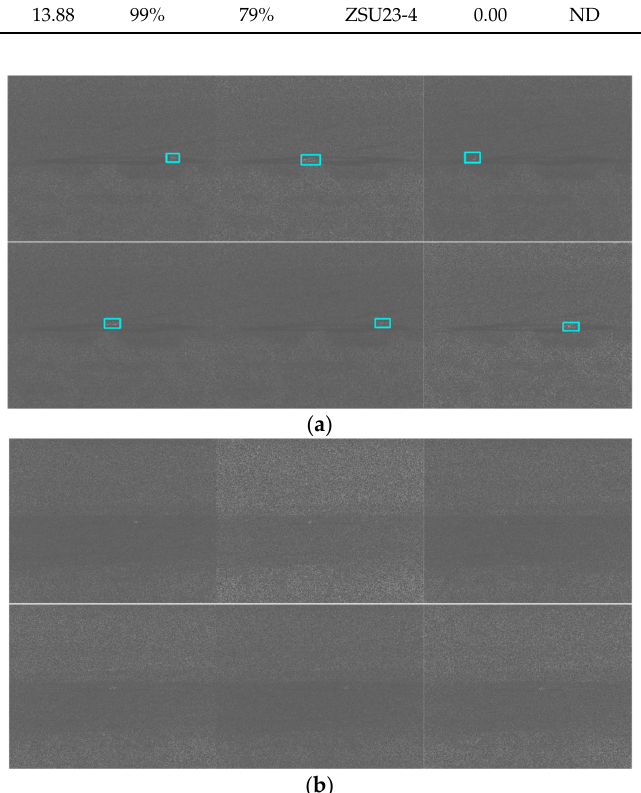
( c ) ( d ) Figure A6. Tracking results for frames 1, 60, 119, 178, 237, and 296 for the PCE 25 (MWIR nighttime) case. The vehicle is SUV. ( a ) 1000 m; ( b ) 2000 m; ( c ) 2500 m; and ( d ) 3500 m.